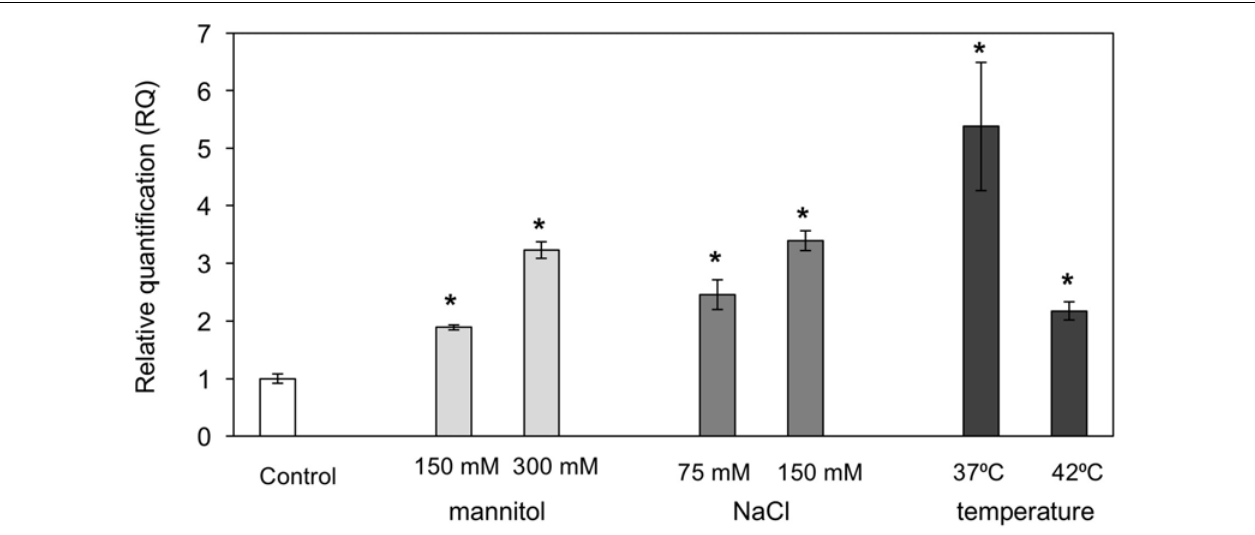
FIGURE 2 | Expression of PaMBF1c in P. alpinum under various abiotic stress conditions. The PaMBF1c expression levels were measured by quantitative real-time PCR with total RNA from P. alpinum gametophores under osmotic stress (150 mM or 300 mM mannitol for 6 h), salt stress (75 or 150 mM NaCl for 6 h) or heat stress (37 or 42 ◦ C for 2 h). The P. alpinum tubulin gene was used as an internal control for normalization. The expression level of PaMBF1c grown on normal BCD was used as a control (calibrator for quantification) and was assumed as 1. Error bars represents standard deviation of means ( n = 3). Asterisks indicate statistical significance in LSD test ( p < 0.05).